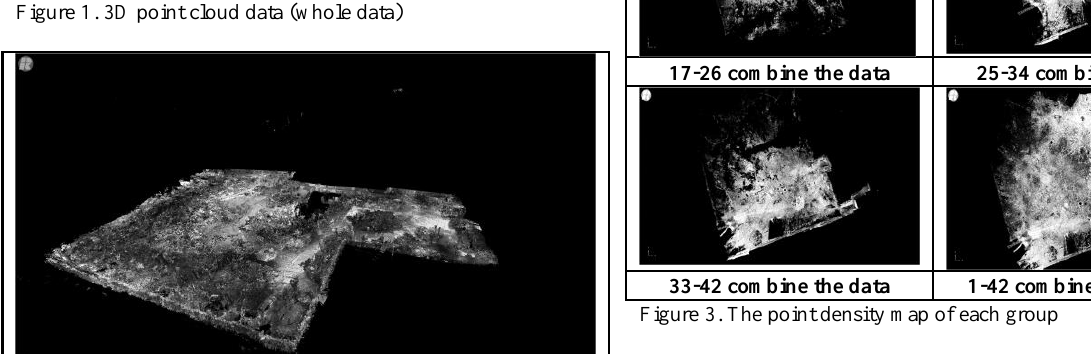
Figure 1. 3D point cloud data (whole data)